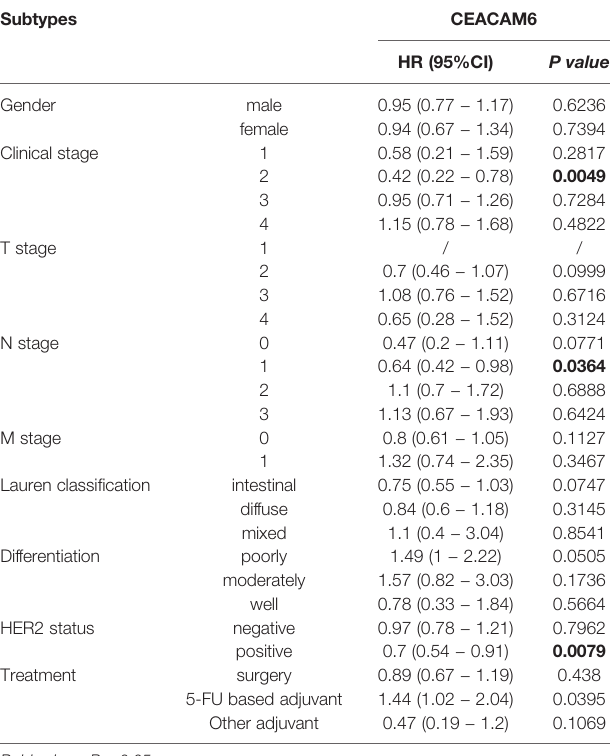
TABLE 1 | Correlations of CEACAM6 mRNA expression with different clinic- pathological factors.